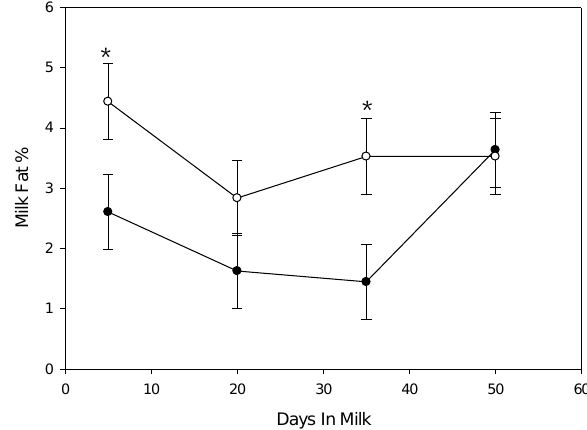
Figure 2. Least square of means values and standard errors for milk fat percent during 50 d in milk in Saanen goats receiving monensin (●), and not receiving monensin (○). Significant time  treatment interactions (p<0.05) were showed by an